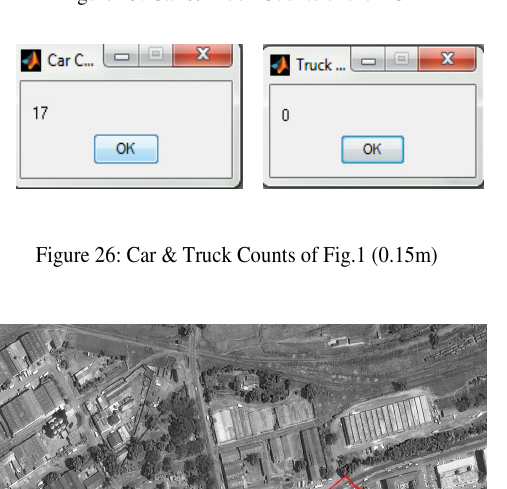
Figure 25: Car & Truck Counts of the ROI